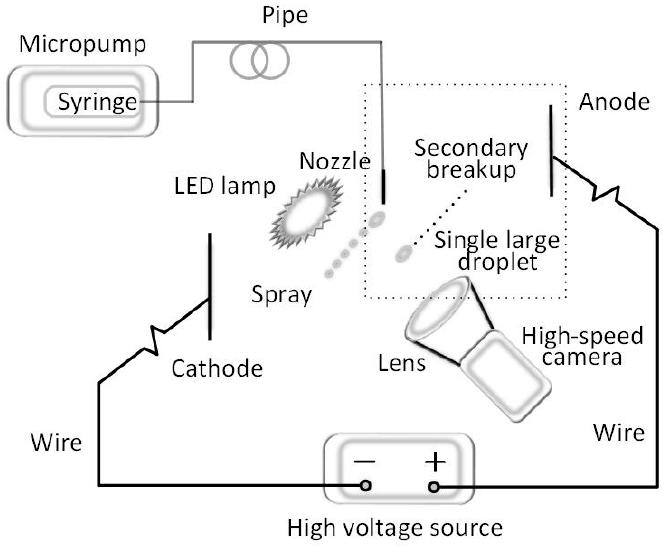
Figure 1. Schematic of the experimental setup for the electrostatic secondary breakup.